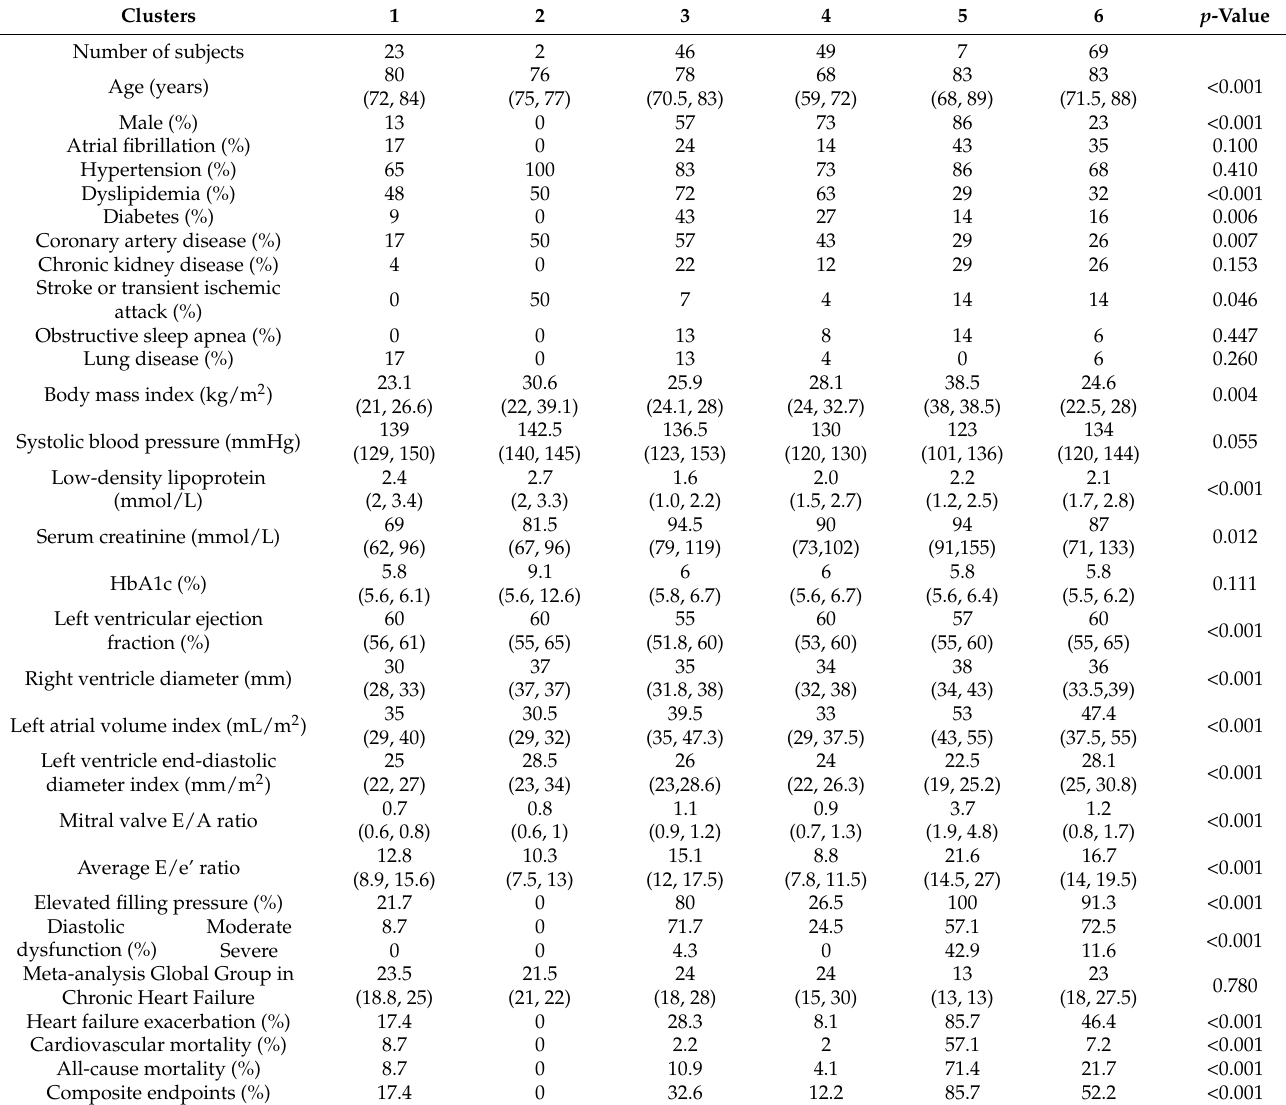
Table 1. Summary of clusters using the hierarchical method ( n =